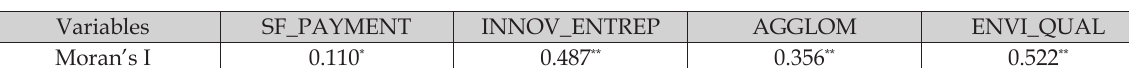
Table 5. Moran’s